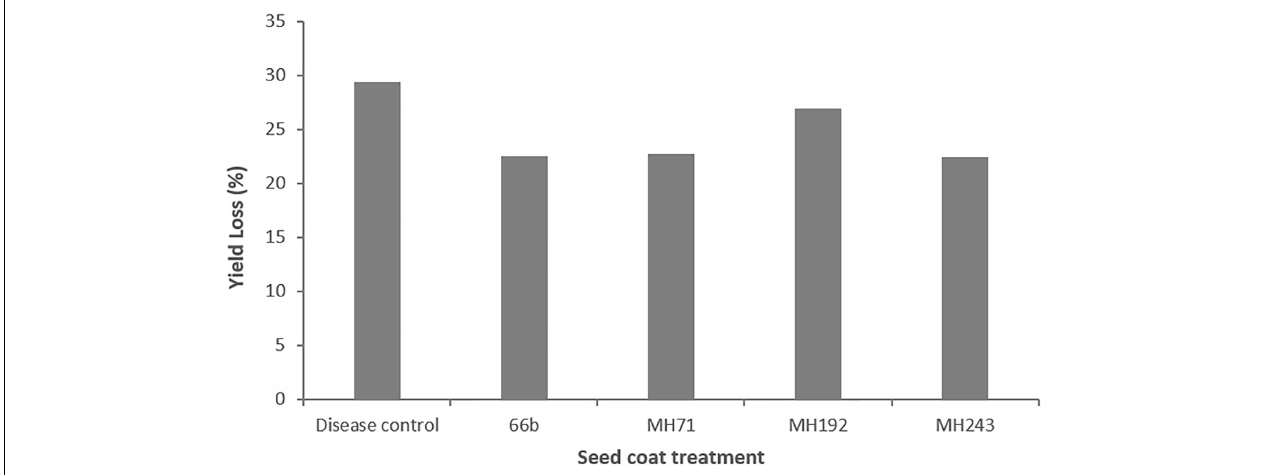
FIGURE 9 | Grain yield losses in plants infected with F. pseudograminearum and treated with a range of Actinobacteria isolates as seed coats in a glasshouse pot experiment. Losses are expressed as a percentage compared to healthy control plants that were grown under the same conditions but not infected with F. pseudograminearum